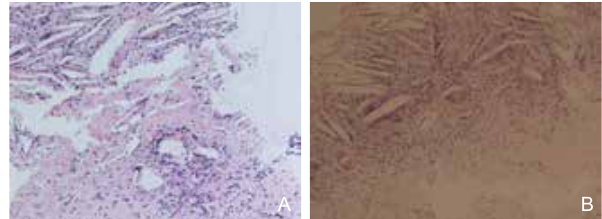
Figure 4 Pathological findings. (A) Optical microscope showed histocytes, epithelial cells aggregation, inflammatory cells infiltrate, and cholesterol crystals appeared in the interstitial tissue; (B) Immunohistochemistry showed CK (-), Vimentin (+), CD68(+), P63 (-), CK5/6 (-), S-100 (-), and Ki-67 (about 20%+).